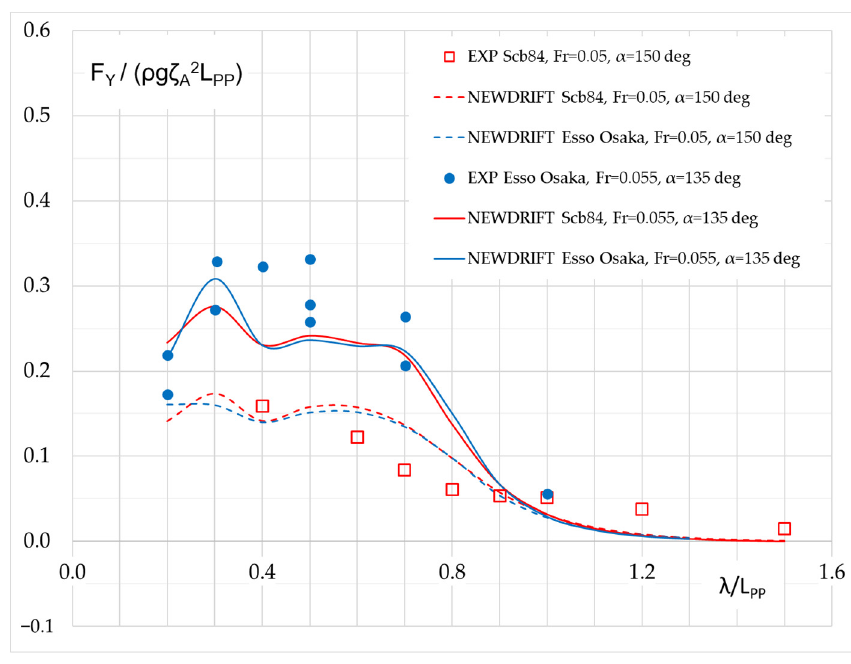
Figure 5. Mean sway force of two ships in regular bow waves at low speeds.